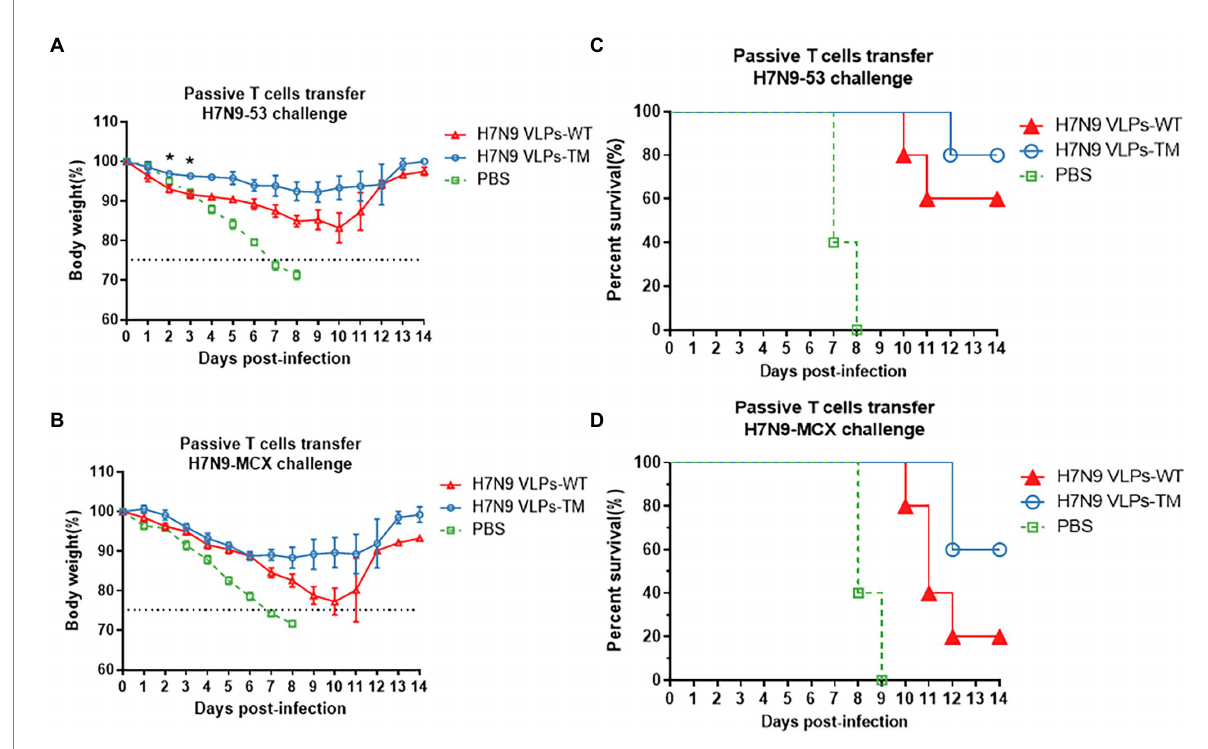
FIGURE 3 Protection of mice passively immunized with T cells and then challenged with homologous and heterologous viruses. (A) Weight loss of challenged with H7N9-53. (B) Weight loss of challenged with H7N9-MCX. (C) Survival rate of challenged with H7N9-53. (D) survival rate of challenged with H7N9-MCX. Statistical difference between two groups was indicated by * p < 0.05, ** p < 0.01, *** p < 0.001.